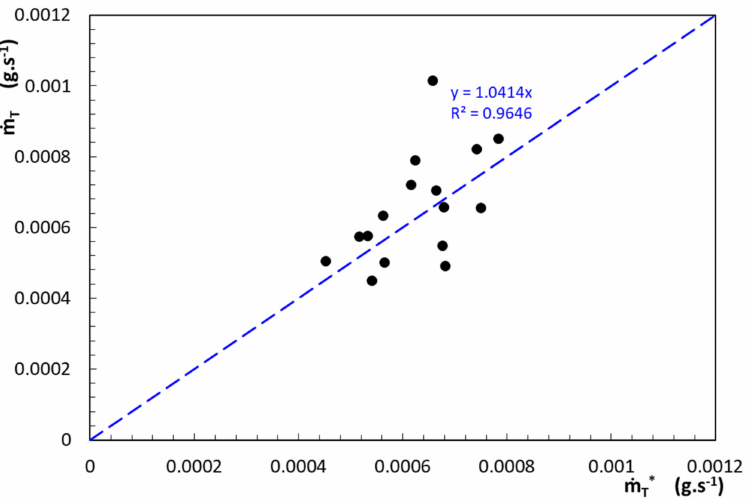
Figure 3. Comparison between direct measurements of mass loss ratio ˙m T of a cigarette with estimated values ˙m T * derived from the rate of combustion from Equation